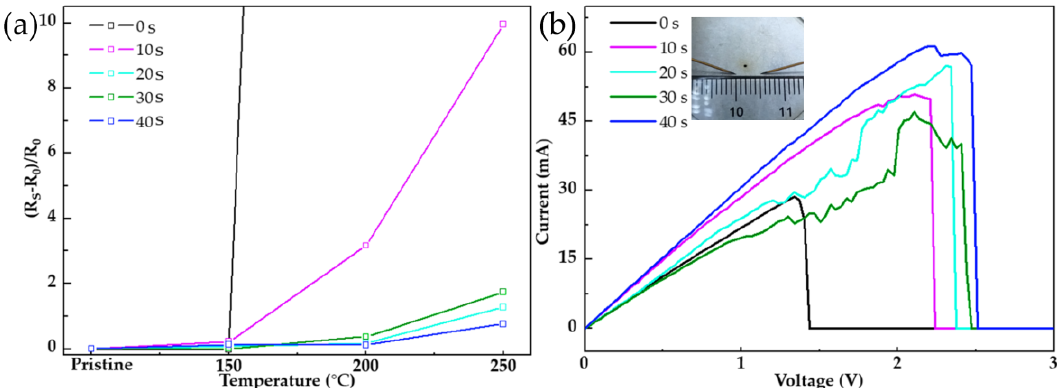
Figure 5. Thermal and electrical stability of films with different deposition times: ( a ) relationship between sheet resistance and temperature and ( b ) the change of failure voltage.